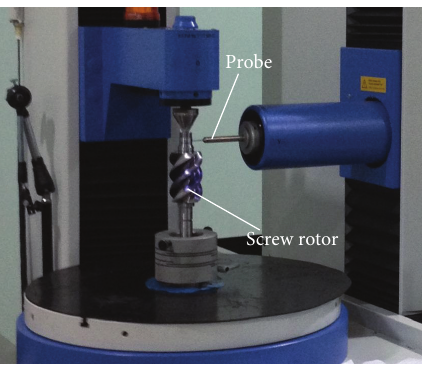
Figure 7: Rotor products.